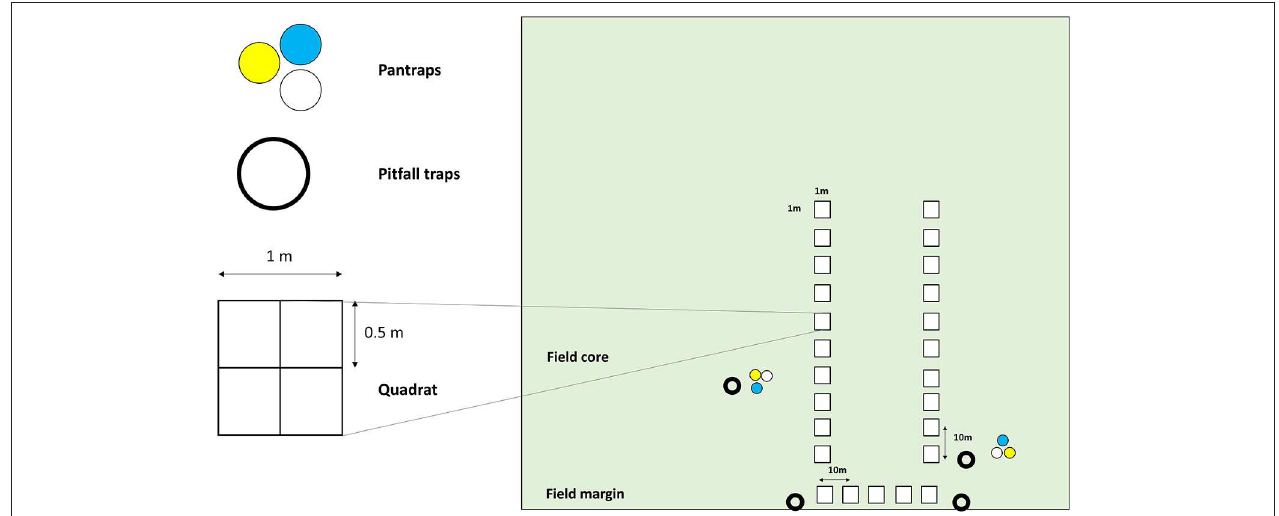
FIGURE 1 | Schematic representation of the biodiversity survey in an arable field.